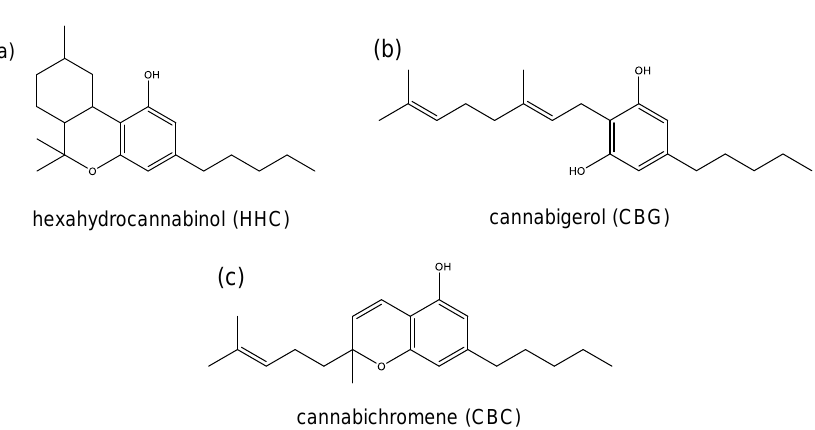
Figure 3. Chemical structures of ( a ) hexahydrocannabinol (HHC), ( b ) cannabigerol (CBG) and ( c ) cannabichromene (CBC).